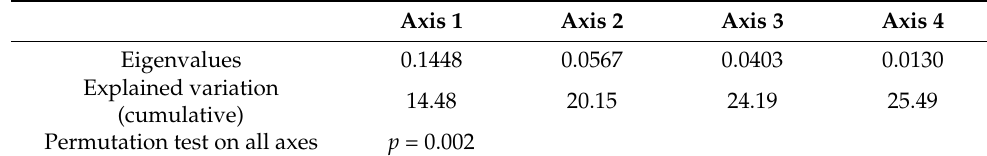
Table 4. Eigenvalues and Explained Variance of the RDA Axes for the ESs.